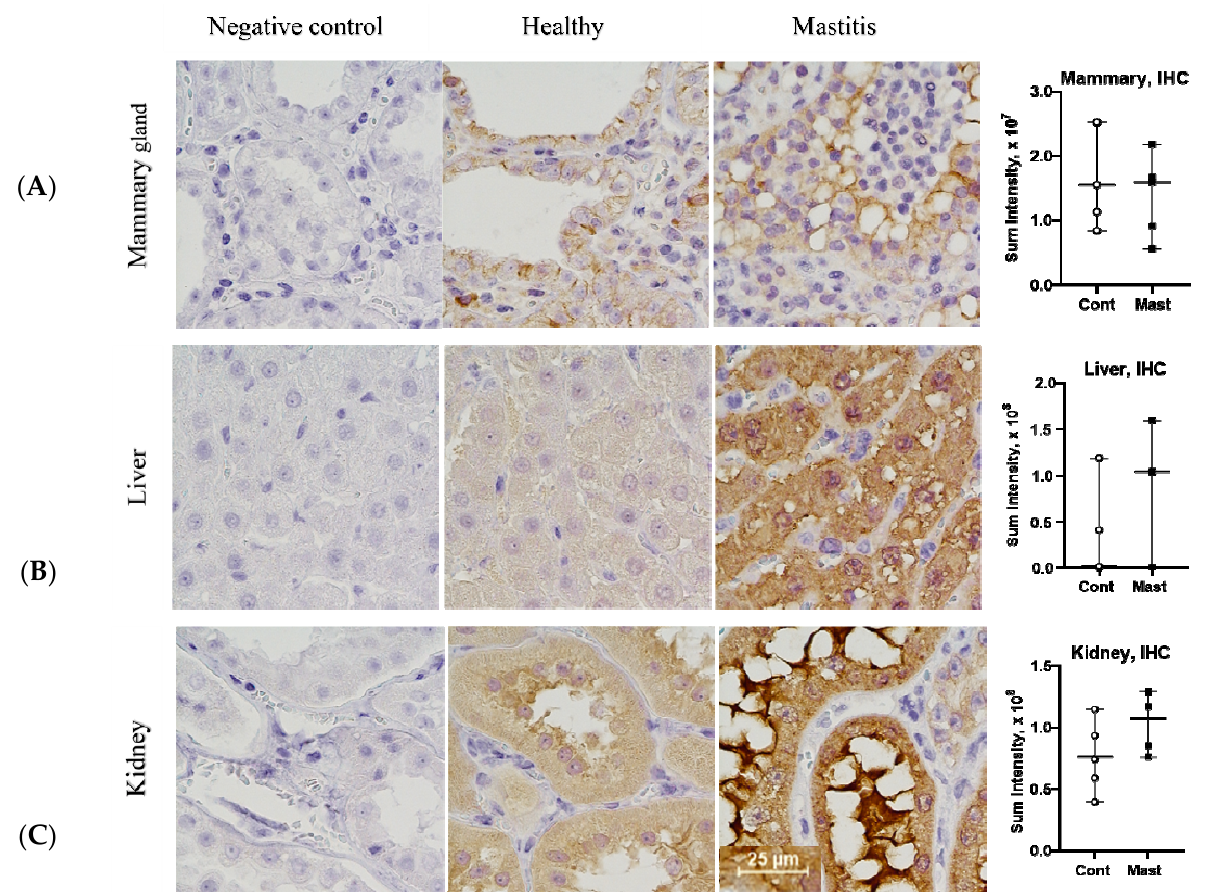
Figure 4. IHC staining intensity for soluble epoxide hydrolase protein (Median and Range, graphs) in the mammary gland ( A ), liver ( B ), kidney ( C ) in cows with mastitis (Mast) and healthy controls (Cont) (1 representative mastitis case and a matched control). IHC, immunohistochemistry, bar—25 µm.